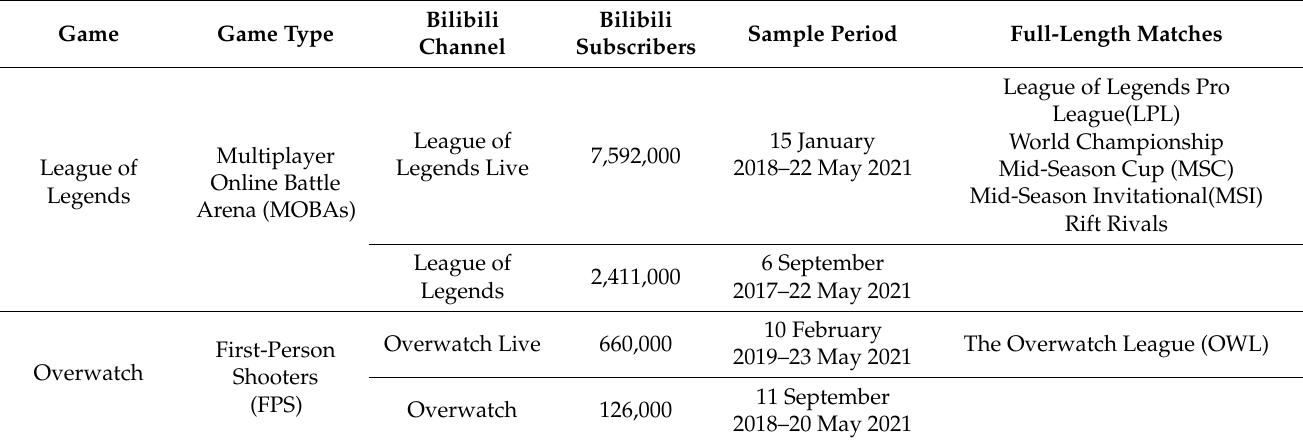
Table 1. Esports Games and Bilibili